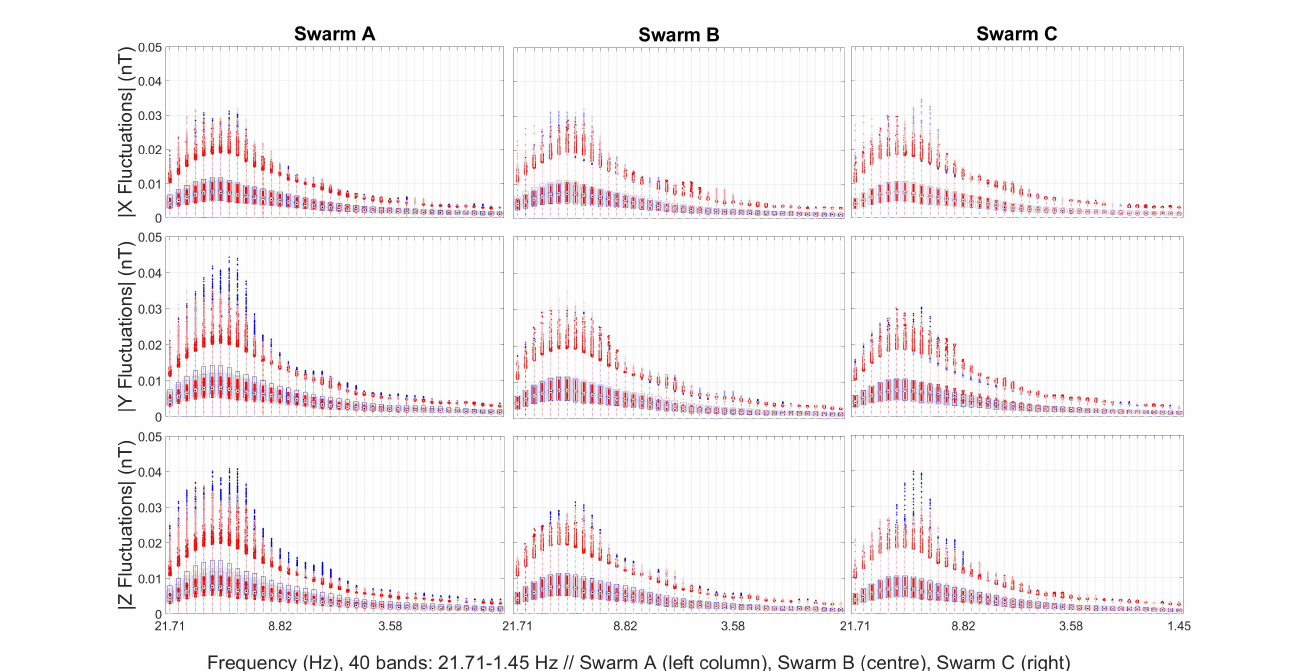
Figure 10. Distribution of Swarm A/B/C VFM magnetic field fluctuations after scalogram processing and grouped in individual frequency bands for an Ariane 5 launch, 25 July 2018, box size ± 10 deg, time span ± 1 day. The frequency band is in log-scale according to ln ( f n ) = 3.1469–0.069315 × n, shown is the range n = {1 – 40}, i.e., the left box plot (n = 1) is f 1 = 21.7062 Hz (Nyquist frequency f s /2 = 25 Hz) and the right box plot (n = 40) is f 40 = 1.4540 Hz. The colour coding is the same as in Figure 2, the geomagnetic activity is | Dst | ≤ 174 nT (start and main phase of a magnetic storm) for the selected time